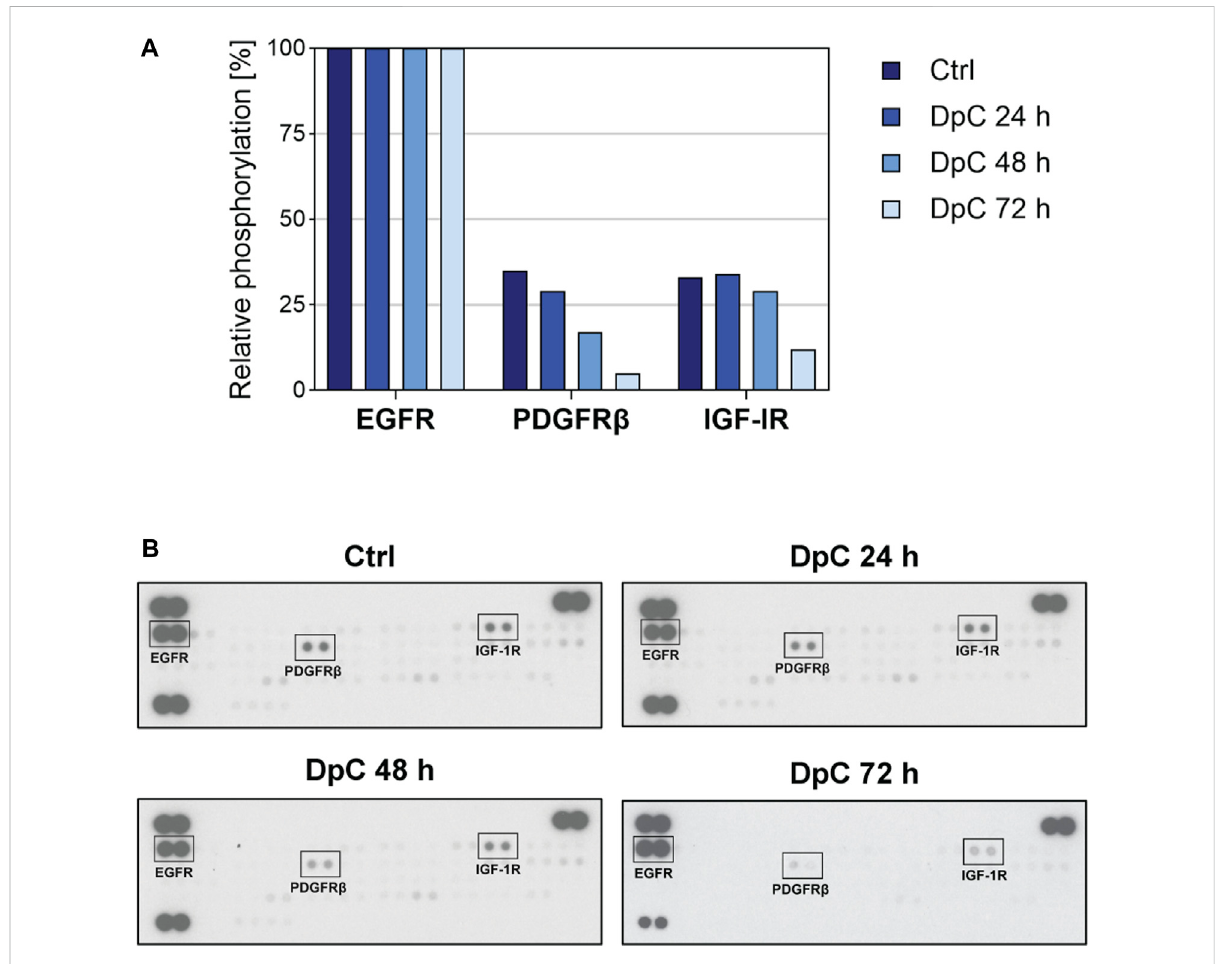
FIGURE 5 Phospho-RTK array screening in the SK-N-BE(2) neuroblastoma cell line after treatment with DpC. The cells were incubated with a control mediumoramediumcontaining6.3 nMDpC(theIC 50 valueobtainedafter72 h)for24,48,and72 h. (A) Evaluationoftherelativephosphorylationof selectedRTKs(EGFR,PDGFR β ,andIGF-1R).ColumnsrepresenttherelativephosphorylationofRTKsassessedasdescribedinMaterialsandMethods. (B) Theimagesofthecorresponding phospho-RTKarraysofuntreated andtreatedcellswerecapturedonan X-ray fi lmataconstantexposure. Selected RTKs are marked by black rectangles. EGFR, epidermal growth factor receptor; IGF-1R, insulin-like growth factor-1 receptor; PDGFR β , platelet-derived growth factor receptor β